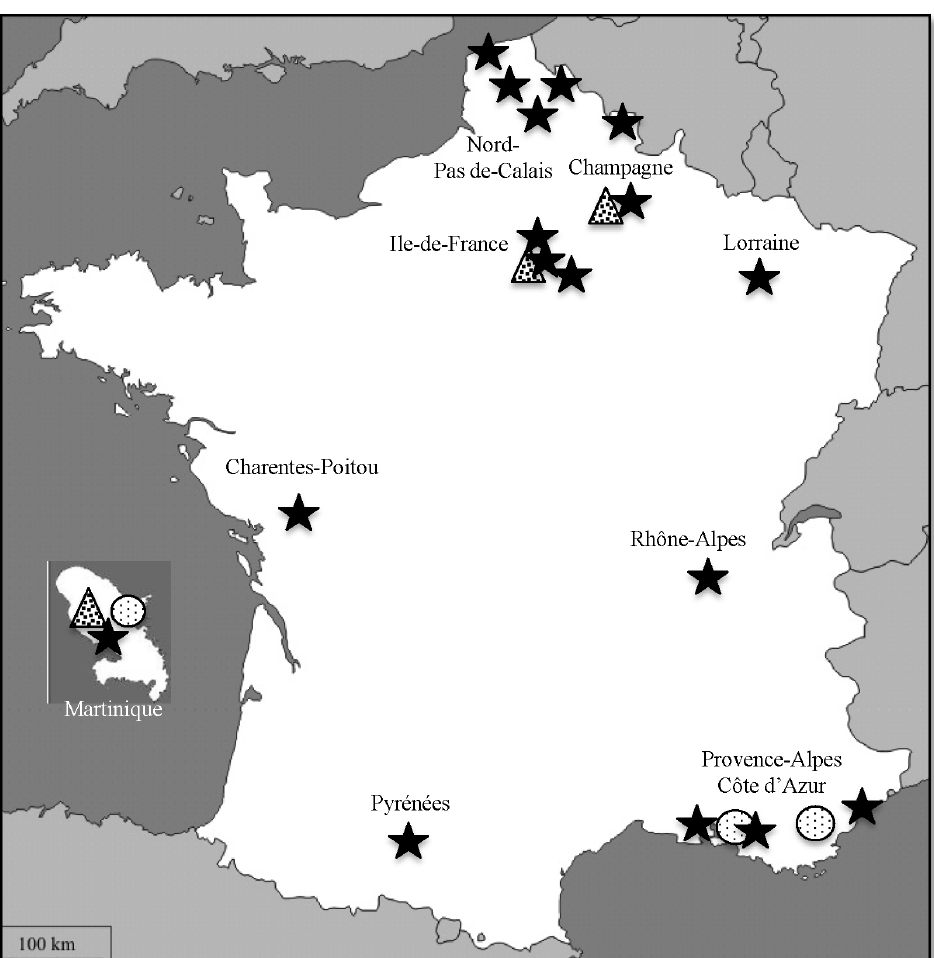
Fig. 1. Geographical distribution of A. baumannii producing acquired oxacillinase enzymes. Carbapenem-hydrolyzing OXA-23, OXA-58 and OXA-24 are indicated by stars, circles and triangles,